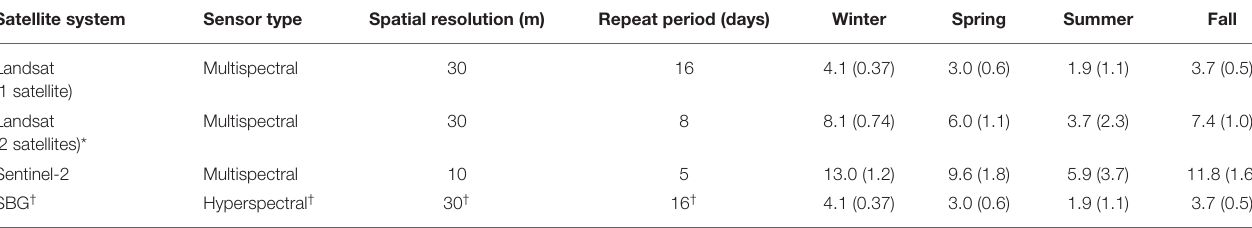
TABLE 1 | Various current and planned satellites systems which are potentially useful for kelp aquaculture. Satellite system